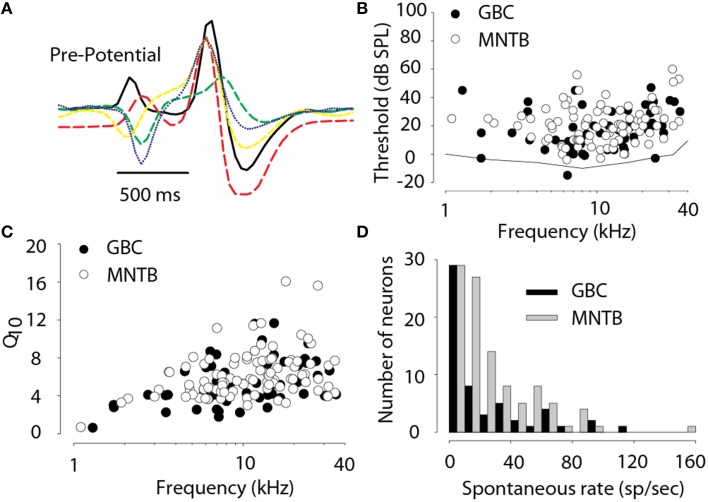
(A) Examples of extracellular voltage waveforms illustrating the pre-potential component in 5 MNTB neurons. (B) Threshold SPL for tones as a function of the characteristic frequency of each neuron. Behavioral audiogram for cat from Heffner and Heffner (1985) (solid line). (C) Frequency tuning bandwidth, Q10 (characteristic frequency divided by the bandwidth 10 dB above threshold), as a function of characteristic frequency. (D) Histogram of spontaneous activity. Data in (B–D) are based on 103 MNTB and 51 GBC neurons.